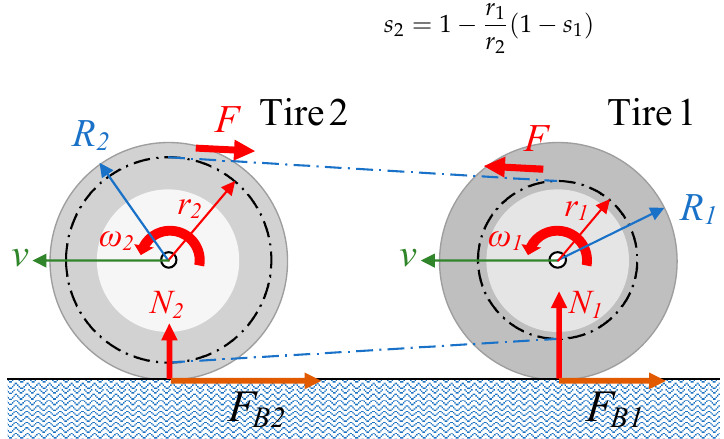
Figure 14. Mechanical properties between two tires.